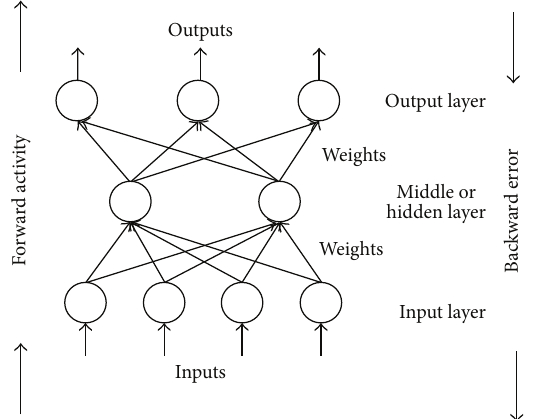
Figure 3: Typical MLP feed-forward artificial neural network structure